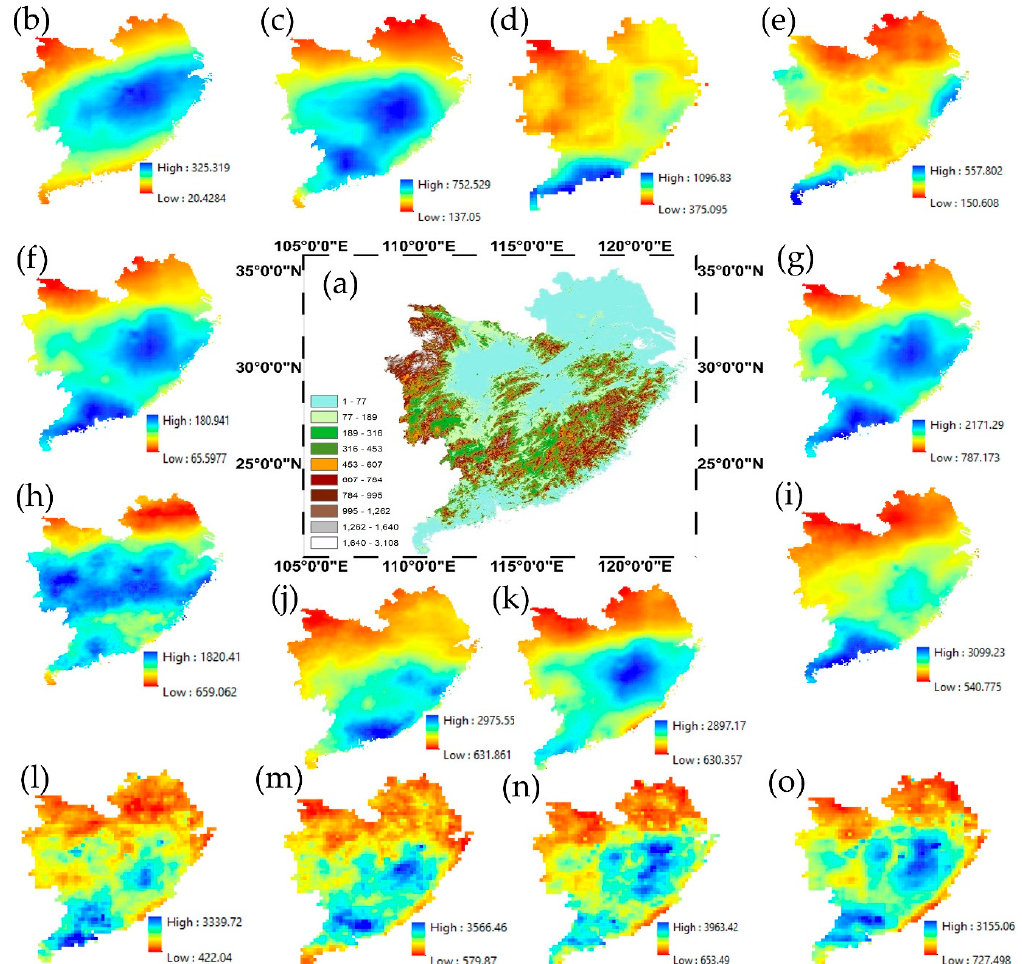
Figure 2. The dataset required for downscaling of the multitemporal precipitation: ( a ) the DEM of study area; ( b ) the GPM-based average winter precipitation; ( c ) the GPM-based average spring precipitation; ( d ) the GPM-based average summer precipitation; ( e ) the GPM-based average autumn precipitation; ( f ) the GPM-based average monthly precipitation; ( g ) the GPM-based average annual (2001–2015) precipitation; ( h ) the GPM-based wet year (2004) precipitation; ( i ) the GPM-based dry year (2001) precipitation, ( j ) the GPM-based annual (2006) precipitation; ( k ) the GPM-based annual (2012) precipitation; ( l ) the TRMM-based annual (2001) precipitation; ( m ) the TRMM-based annual (2006) precipitation; ( n ) the TRMM-based annual (2012) precipitation; ( o ) the TRMM-based average annual (2001–2015) precipitation, respectively.